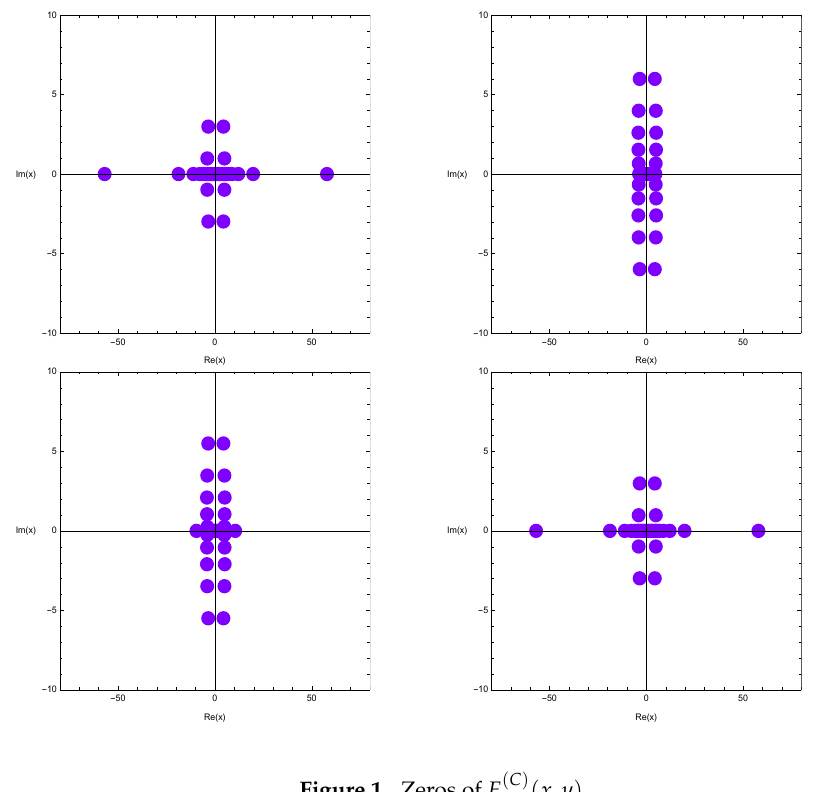
Figure 1. Zeros of E